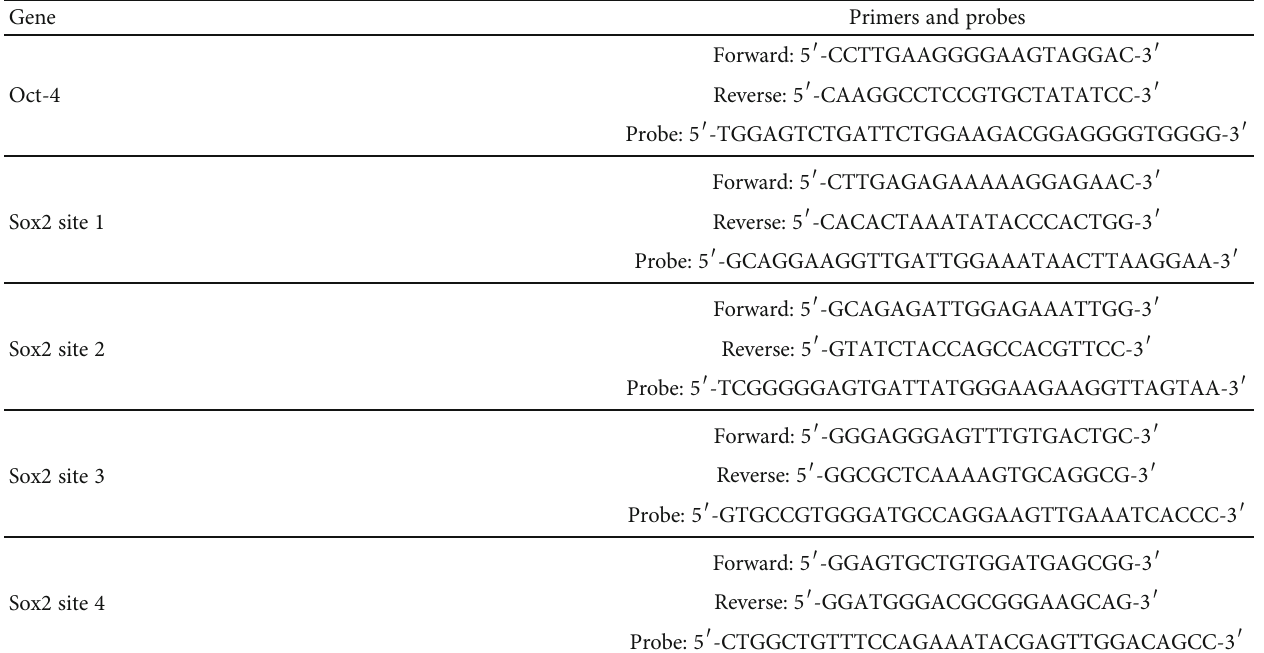
Table 1: Primers and probes used in ChIP and